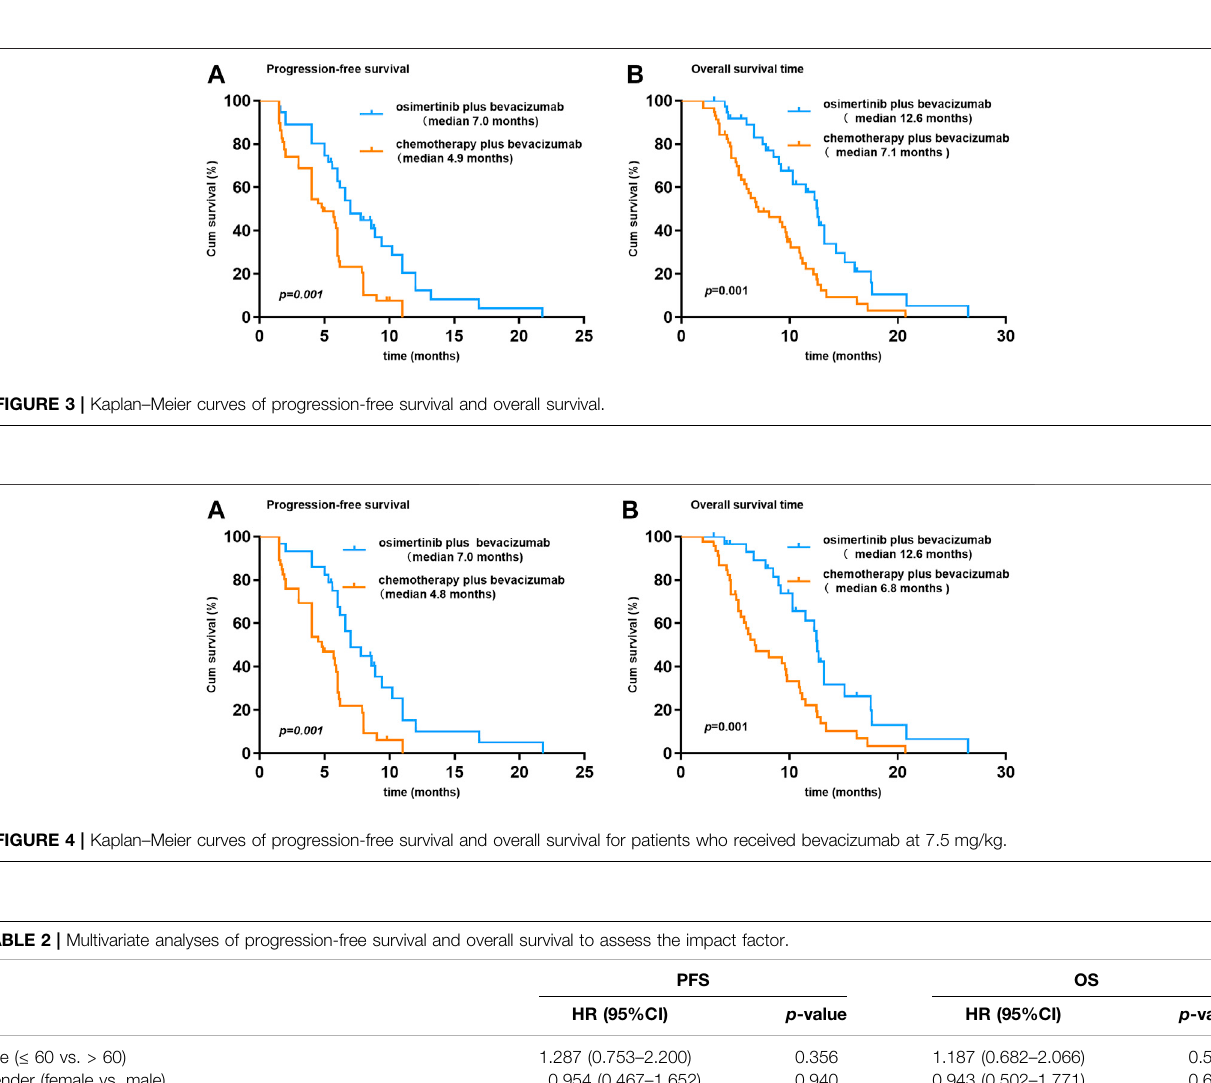
TABLE 2 | Multivariate analyses of progression-free survival and overall survival to assess the impact factor. Age ( ≤ 60 vs. >